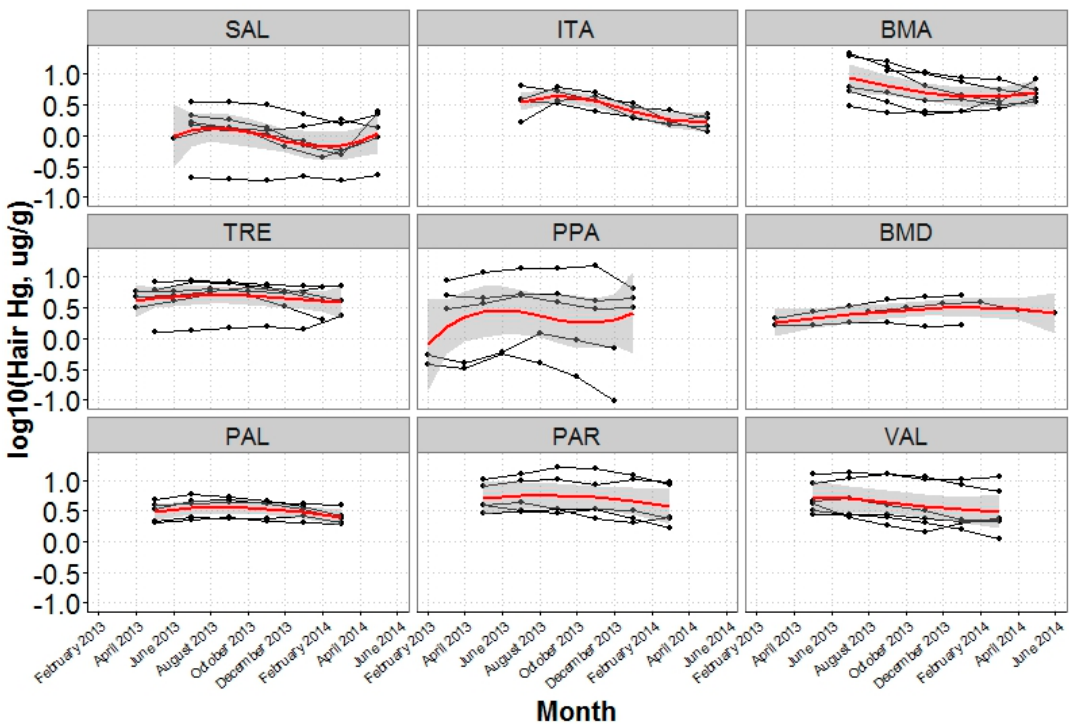
Figure 4. Temporal mercury exposure over a year timeframe was measured in women of child bearing age (WCBA) ( n = 46). Differences by community are depicted with black lines connecting hair mercury contents (log 10 ) of each individual woman over 2-cm (approximately 2 month) intervals. The modeled relationship with cubic splines is indicated by the red line with the grey area indicating the 95% confidence interval. Rainy season was considered as the period from December to March, post-rainy season from April to July, and dry season from August to November. Upstream communities (SAL, ITA, and BMA) are indicated in the top row and downstream communities (TRE, PPA, BMD, PAL, VAL, and PAR) in the middle and bottom rows.